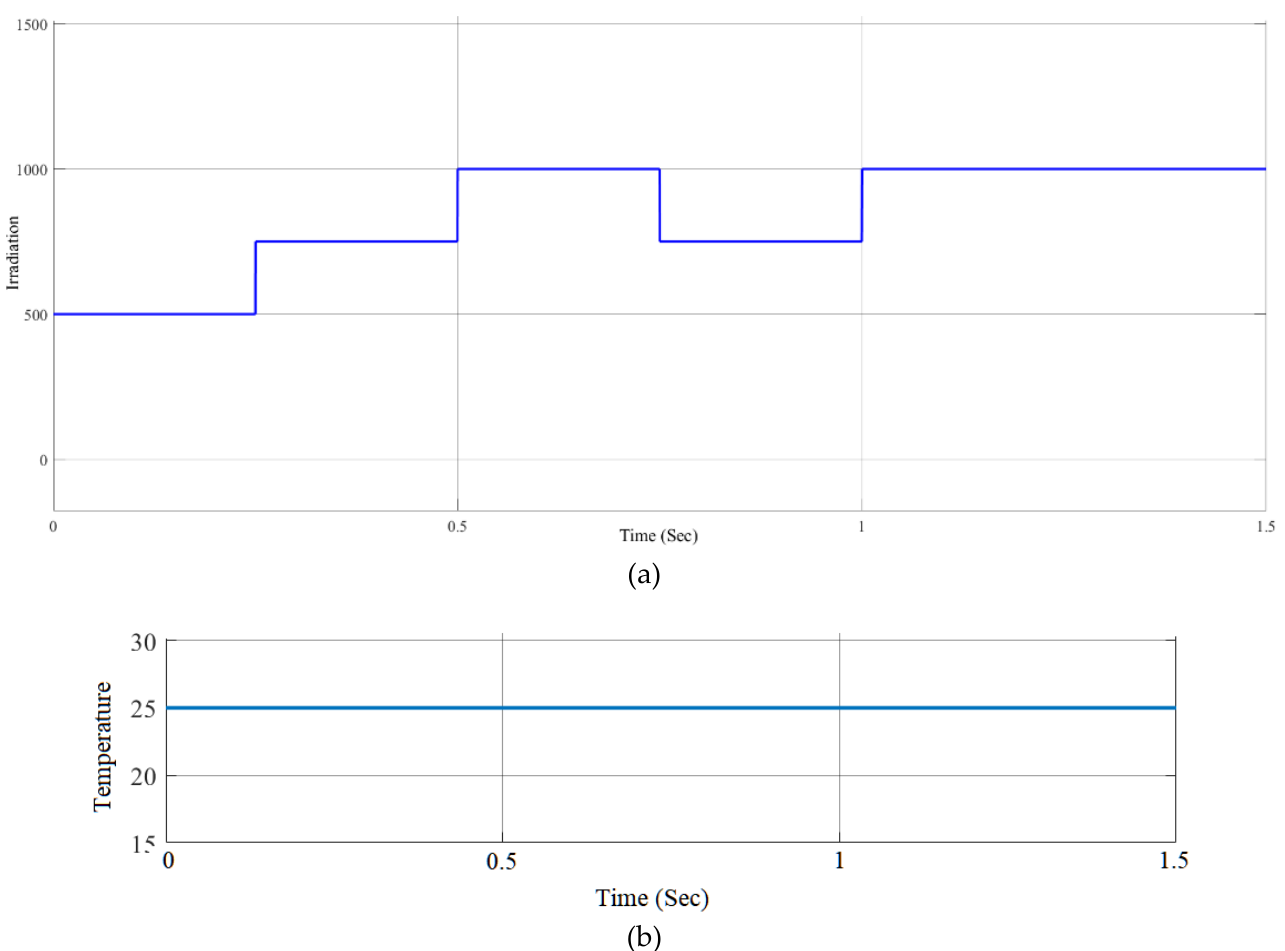
Figure 4. Performance of system ( a ) irradiationand ( b ) temperature. Figure 5 shows the PV indices such as solar insolation level; PV output power and proposed converter voltage. From the above Figure, it is also concluded that the energy obtained from PV is maximized with the help of the proposed converter and a stable power with less oscillations is